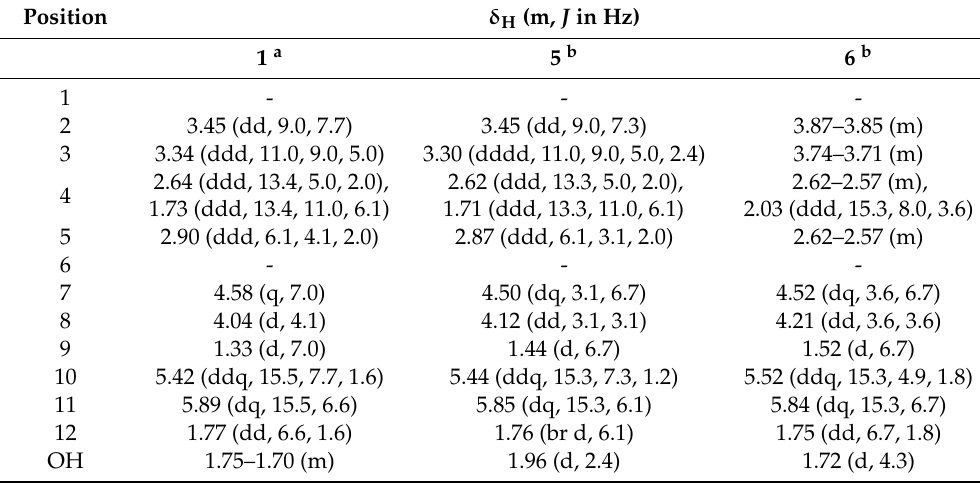
Table 1. Comparison of 1 H-NMR data of 1 with 5 and 6 in CDCl 3 .